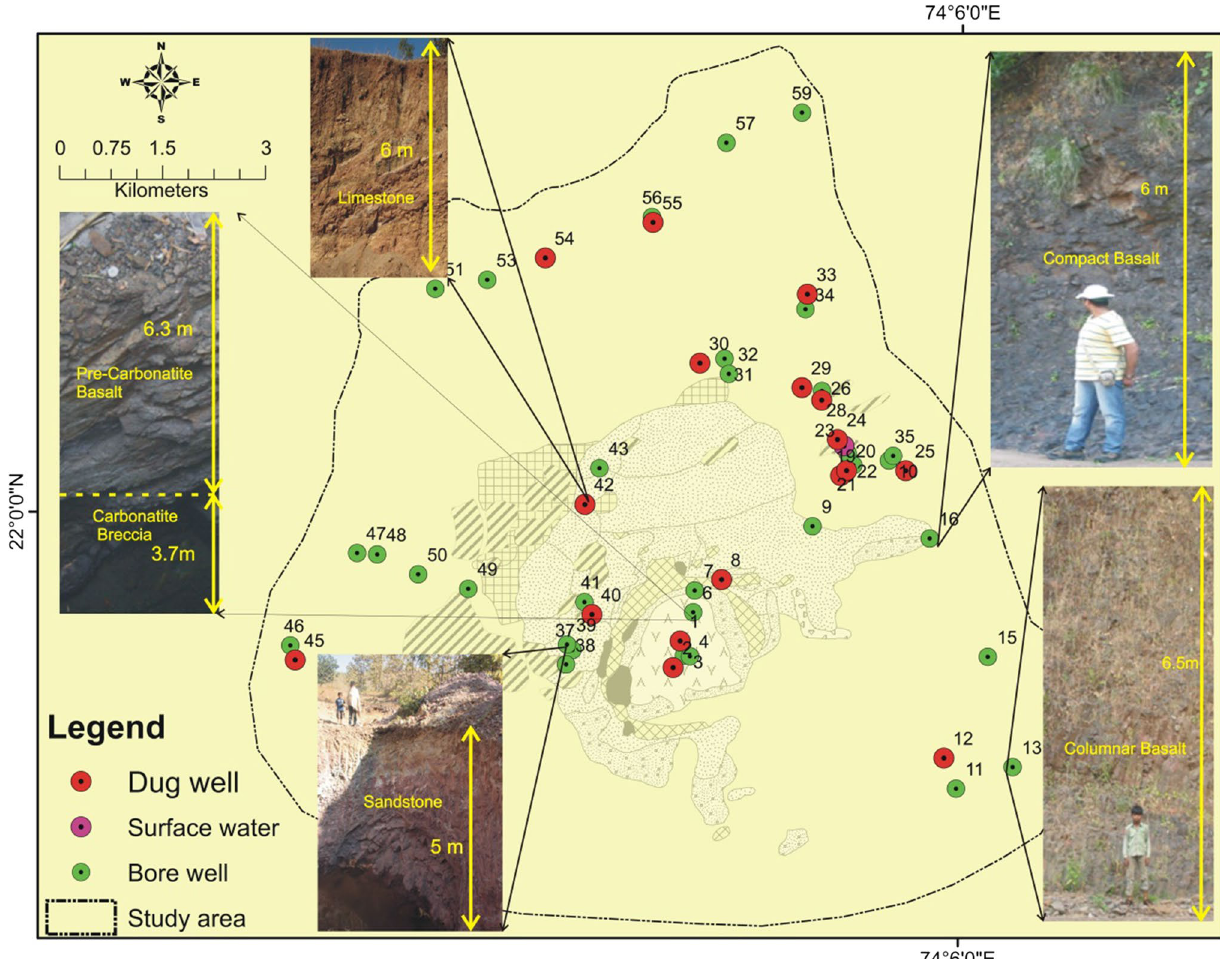
Fig. 2 Geological profile at different